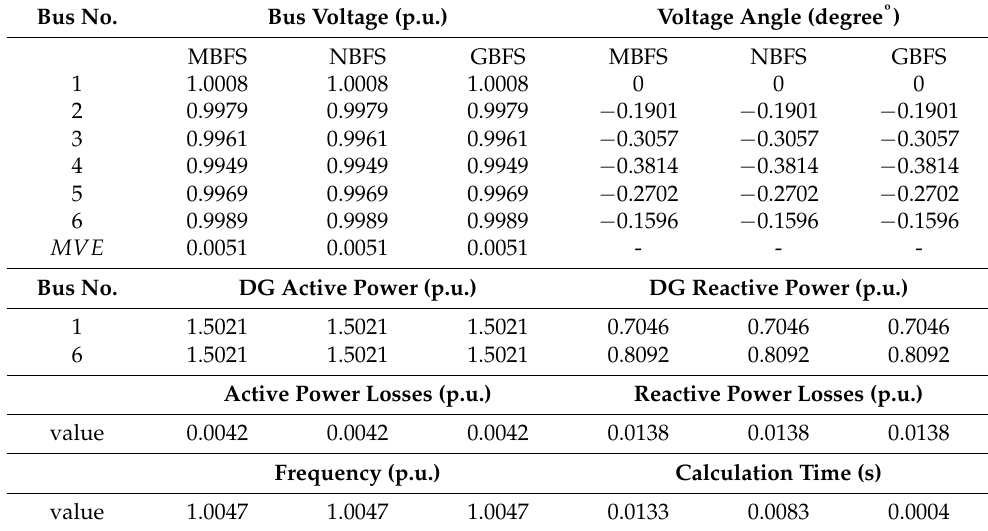
Table 5. Load flow analysis results for the six-bus system considering test 1 of Table 4. Bus No.